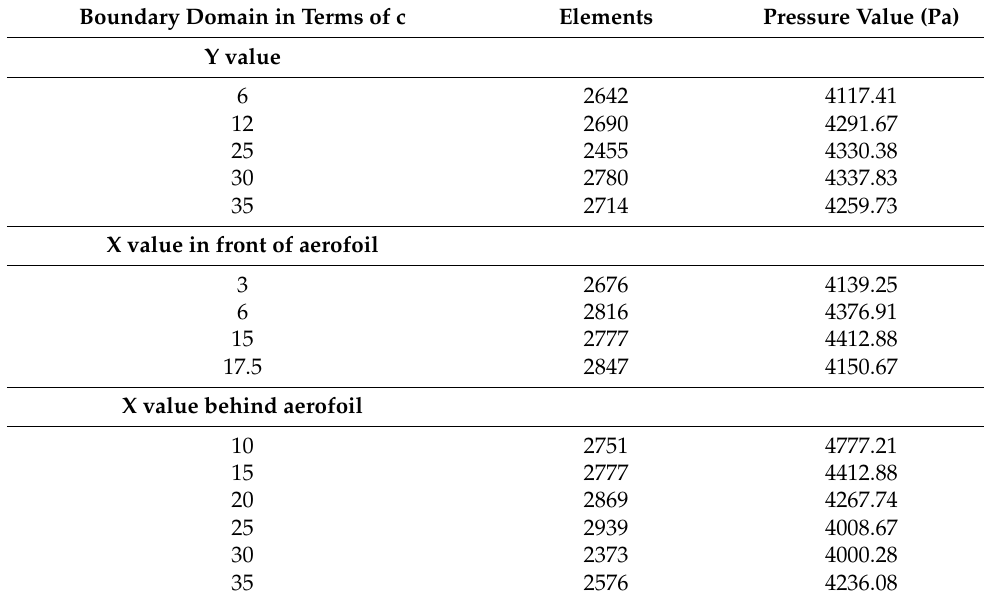
Table 8. Pressure fluctuation as boundary domain changes